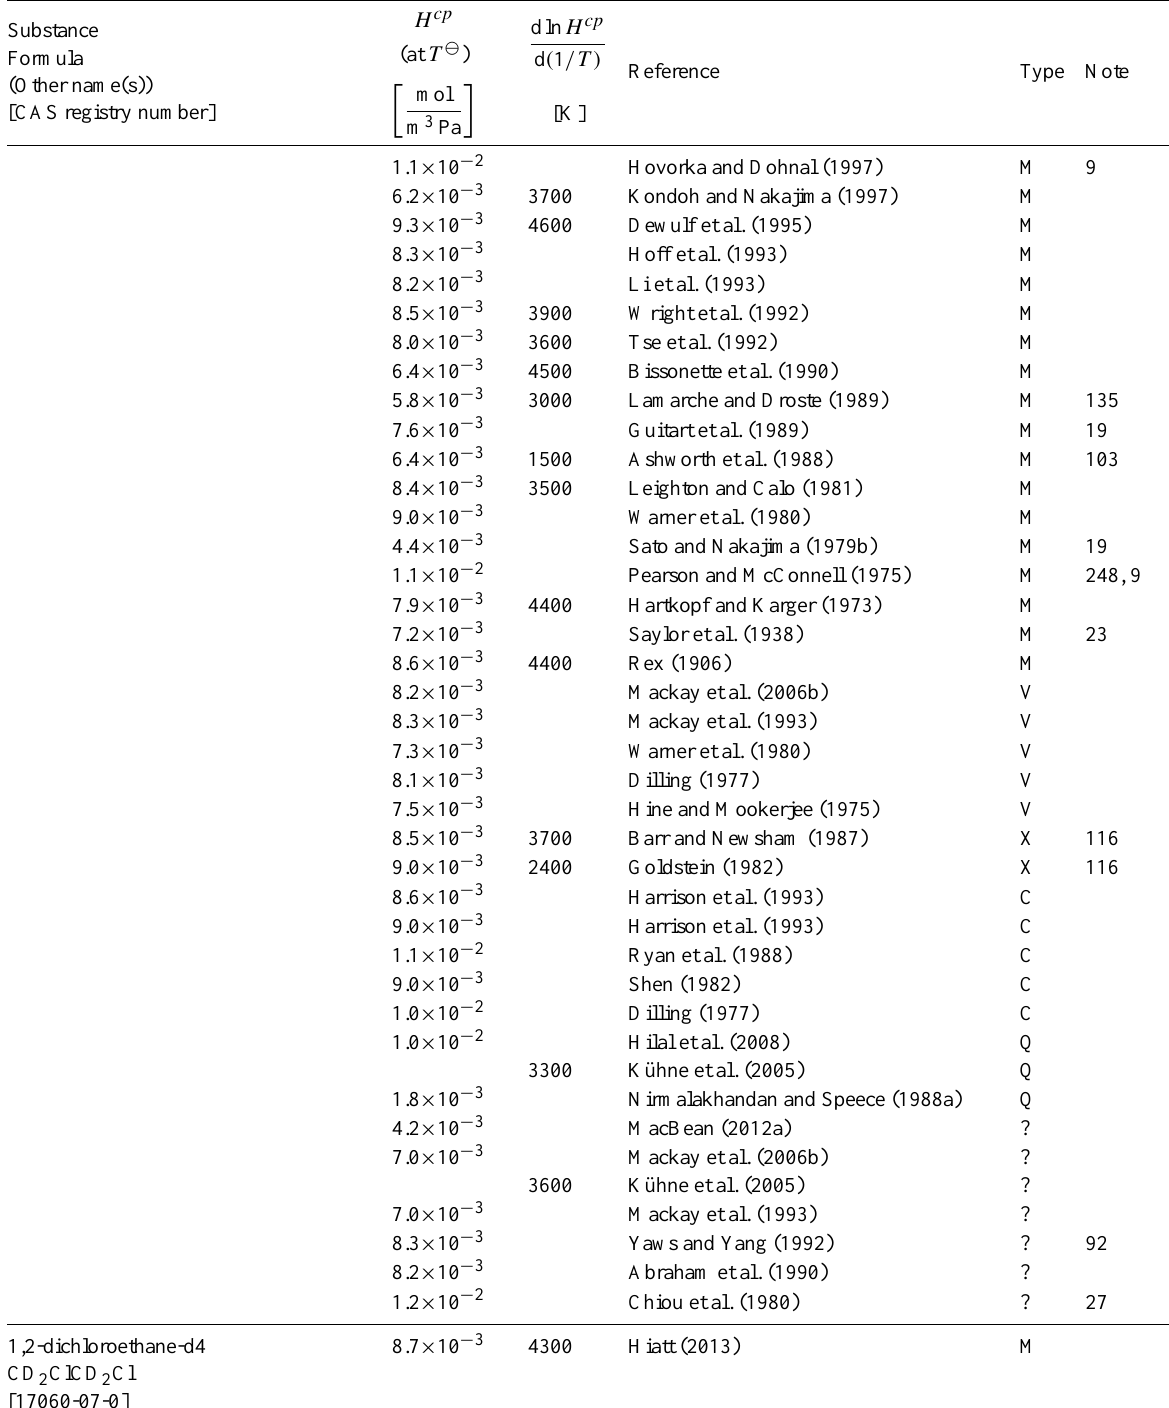
Table 6: Henry’s law constants for water as solvent (...continued)